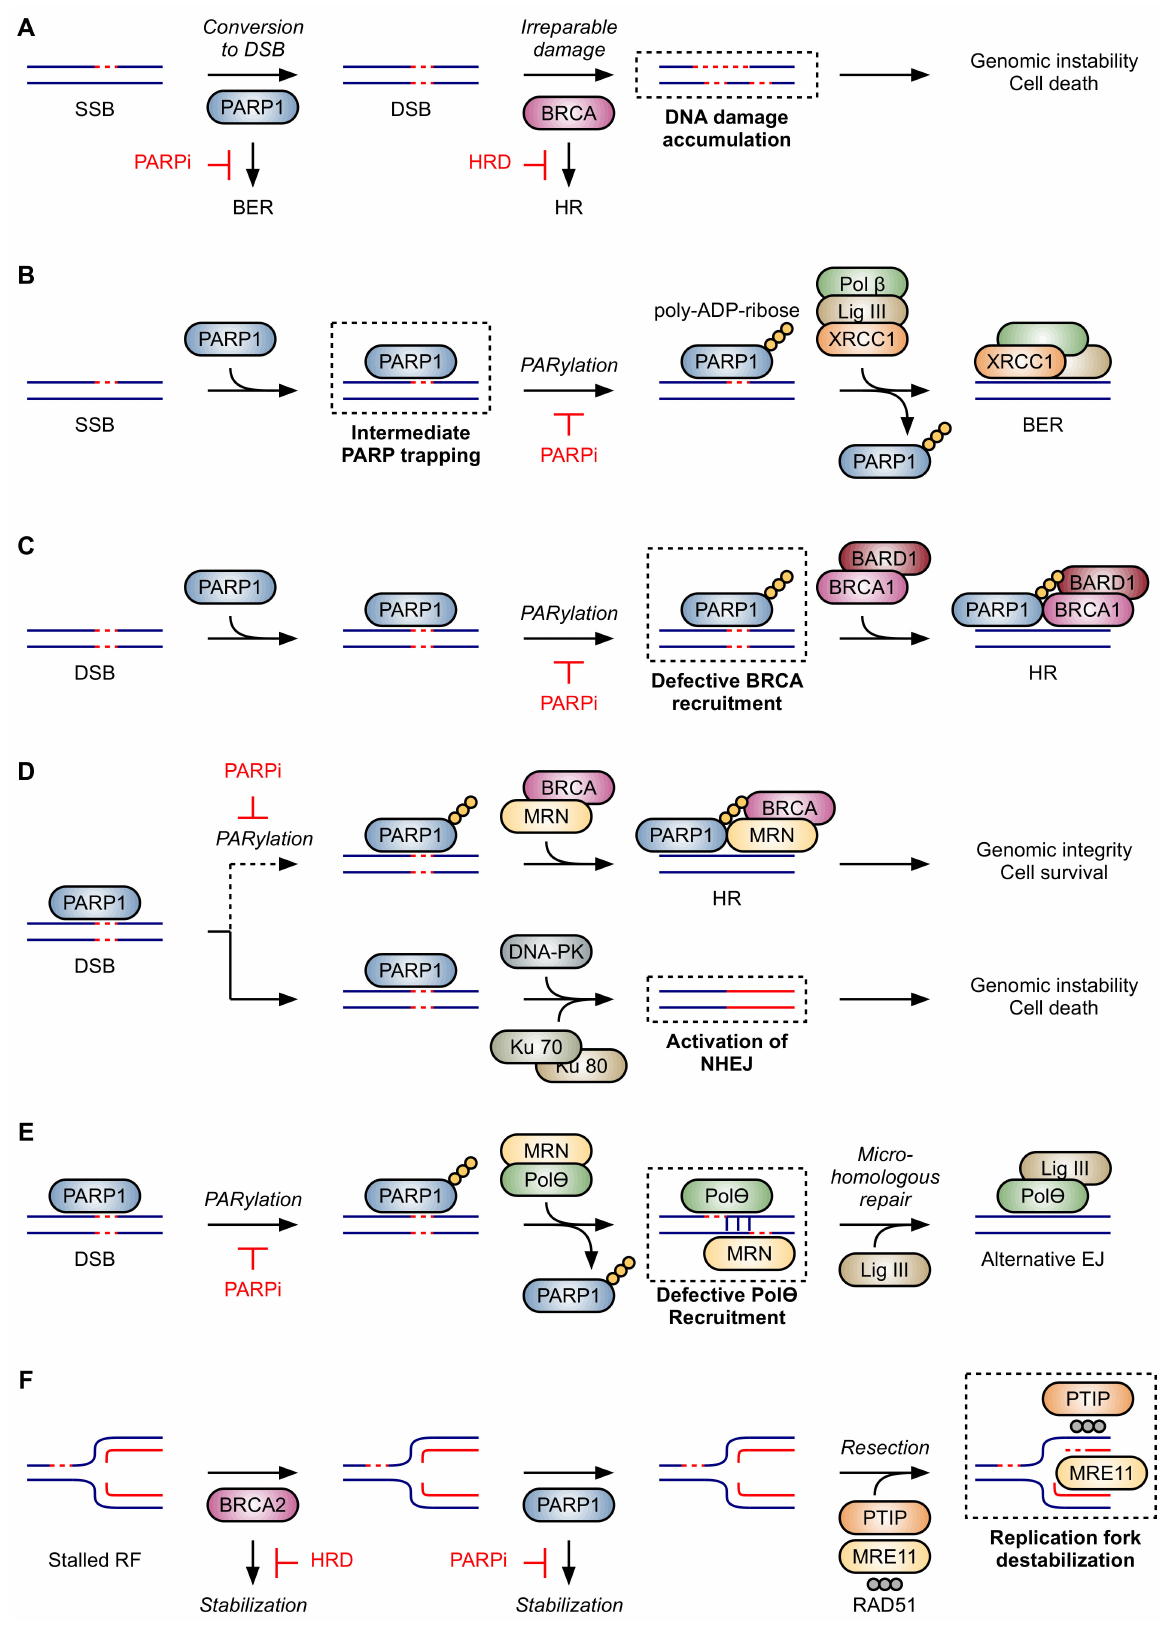
Figure 2. Proposed Mechanisms of Synthetic Lethality with PARP Inhibitors. ( A ) Inhibition of base excision repair (BER). Under physiologic conditions, DNA single-strand breaks (SSBs) are repaired via BER in a process that depends on